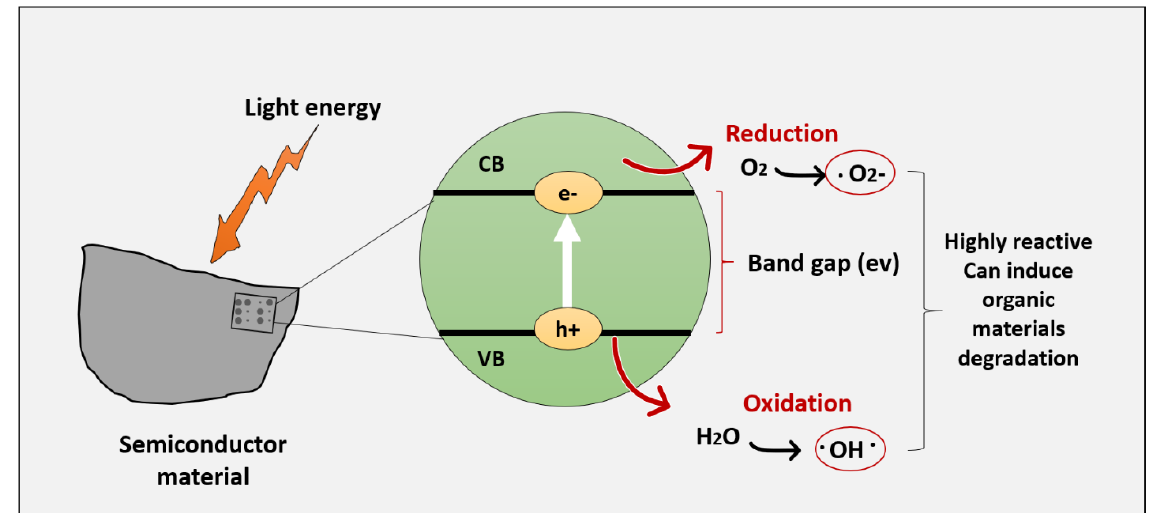
Figure 2. General photocatalytic mechanism. Adapted from [38] with